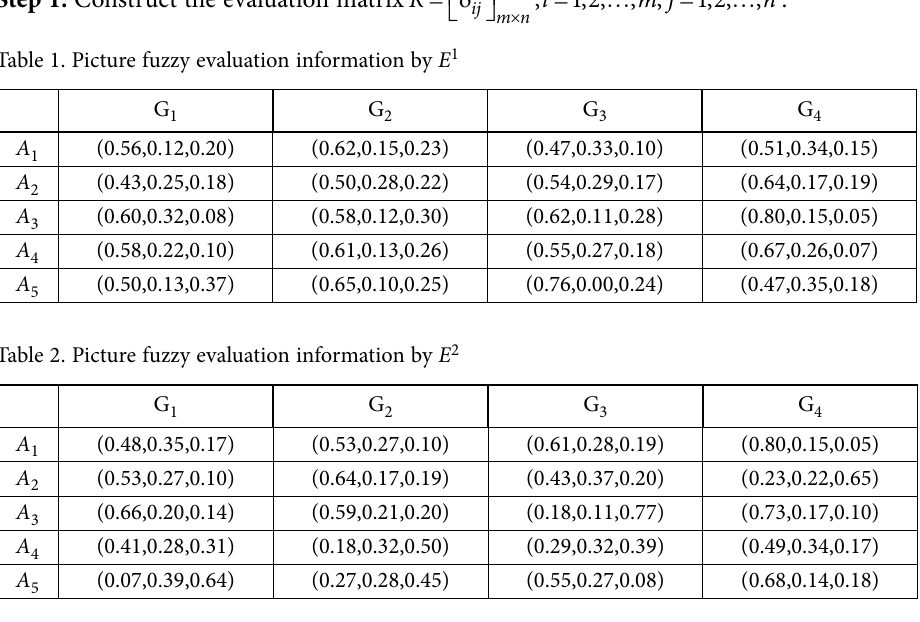
Table 3. Picture fuzzy evaluation information by E